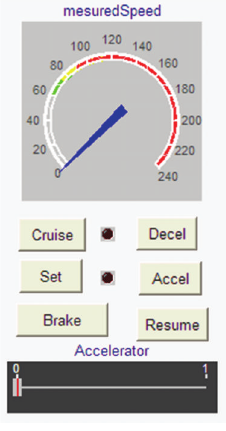
Figure 26: A panel diagram.